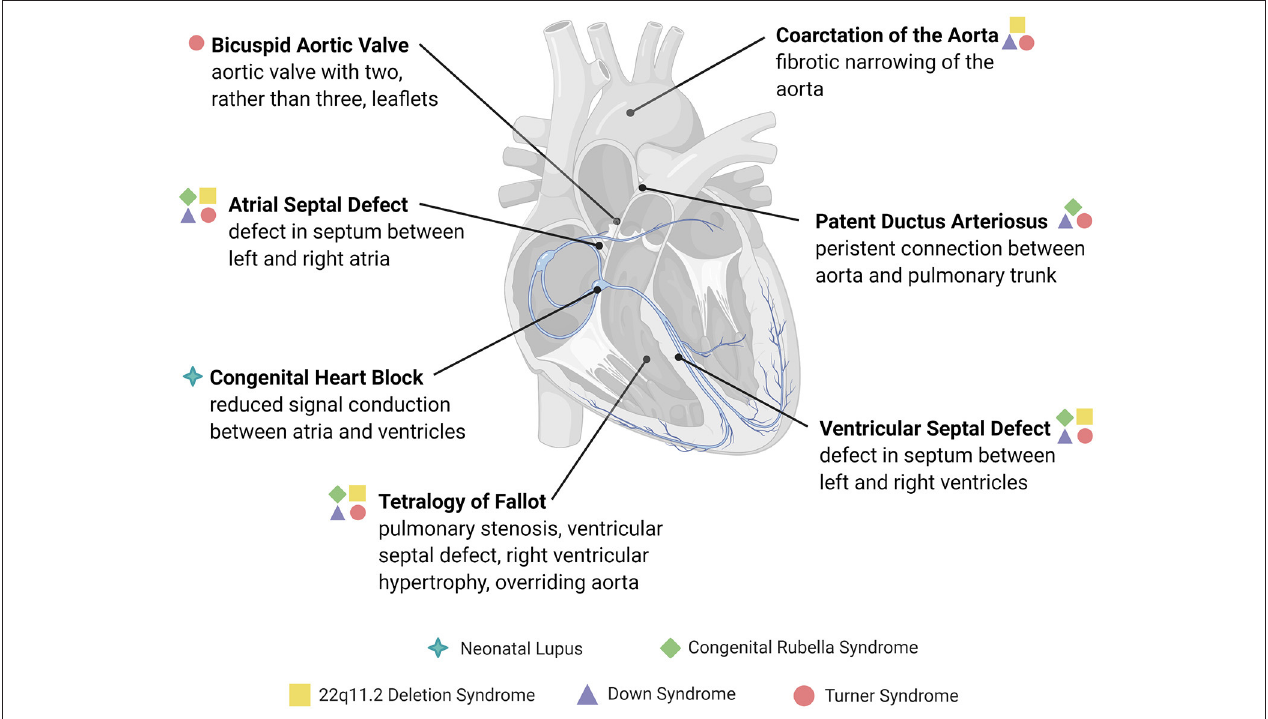
FIGURE 1 | Overview of congenital structural heart defects associated with immune or inflammatory reactions. Congenital heart diseases are conditions present at birth and are mainly comprised of abnormalities in the development of the heart chambers, valves, or the conduction system, or the persistence of congenital structures that typically involute after birth. The heart defects depicted here are examples of those associated with an immune cause or reactive inflammatory changes, many of which are associated with genetic and immune